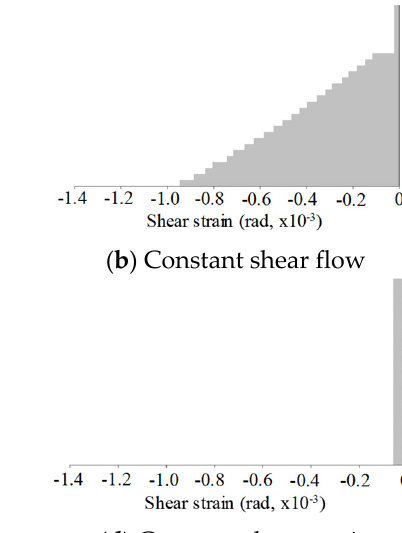
Figure 13. Shear strain distribution over cross section (at critical section, 54.7 kN V